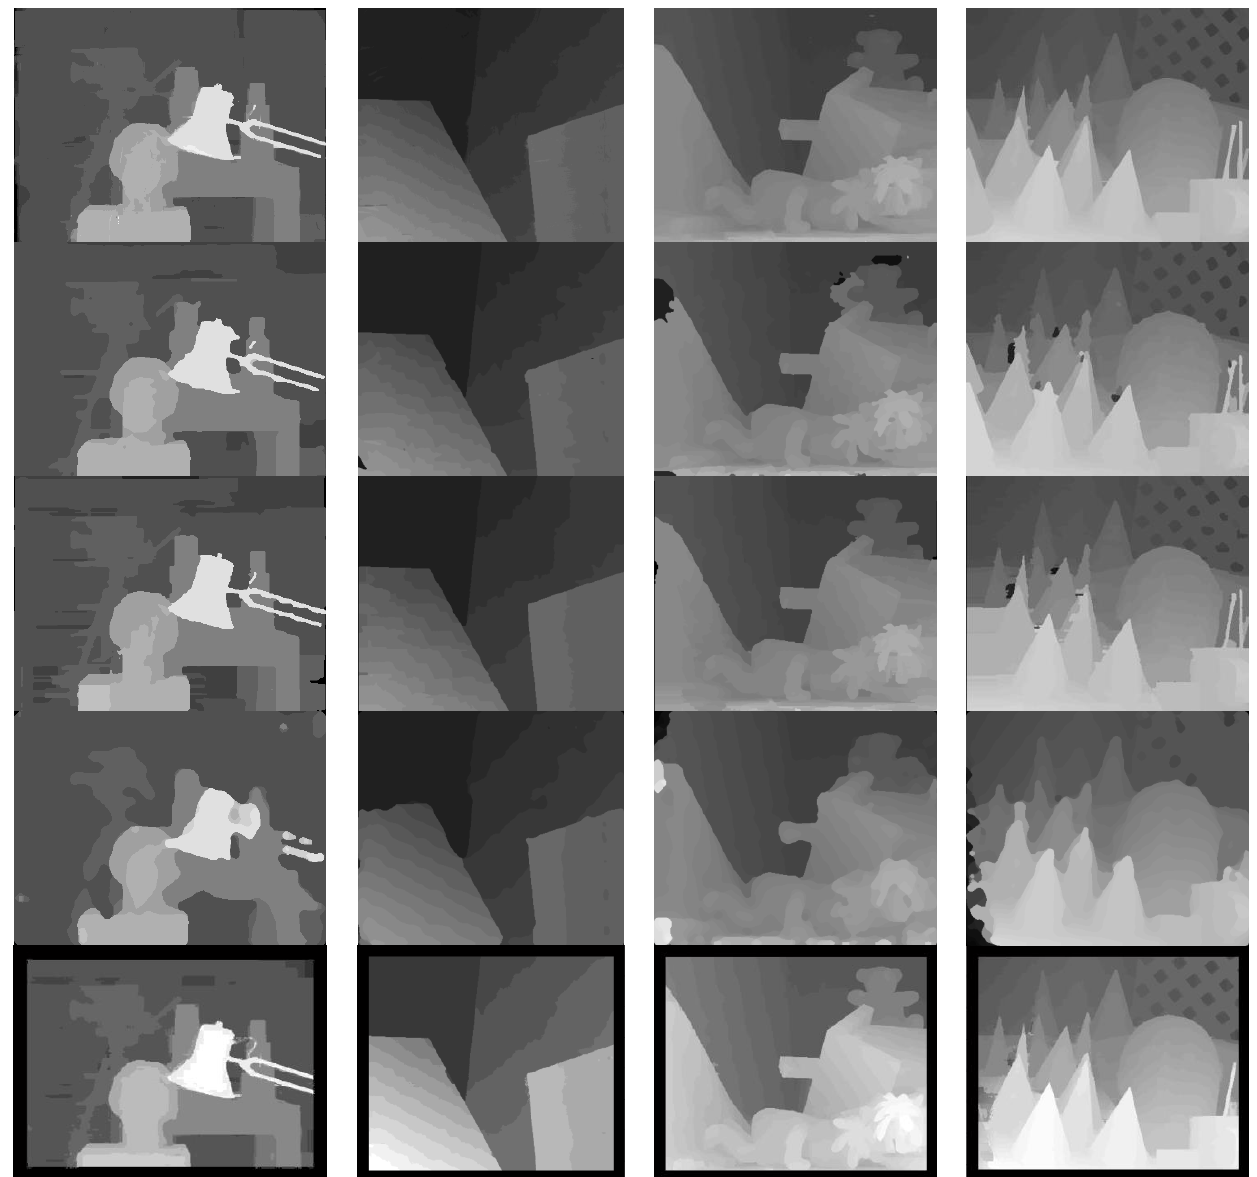
Figure 10. Results of different methods. LLR (first row), imprNLCA (second row), Borders (third row), LCVB-DEM (forth row) and our method (last